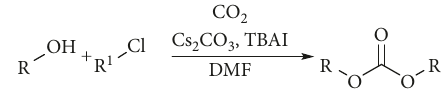
Figure 1: Method by Salvatore et al. [21–23] for the synthesis of carbonates using nonradioactive CO 2